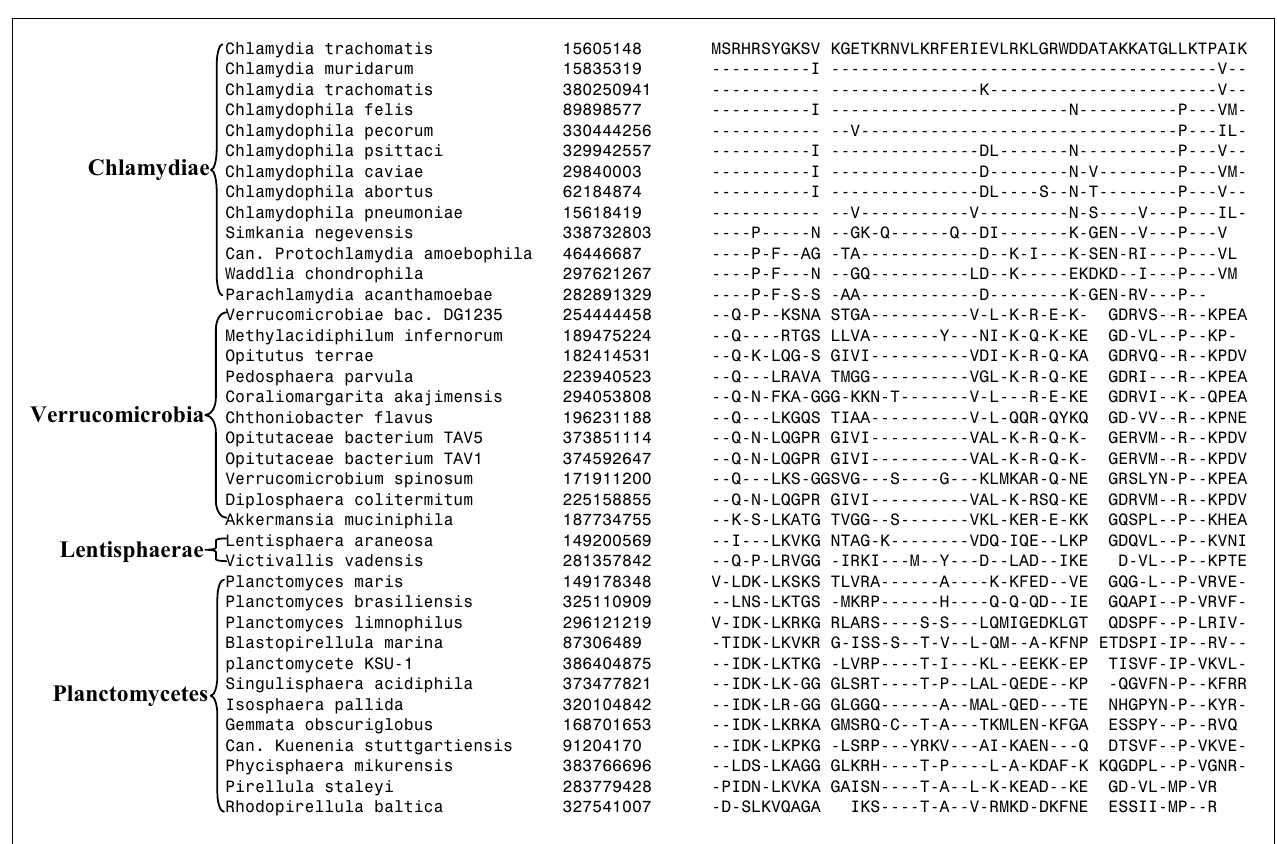
except Poribacteria. In Blastp searches, no homolog of this protein is detected in any other bacteria outside of the PVC clade of